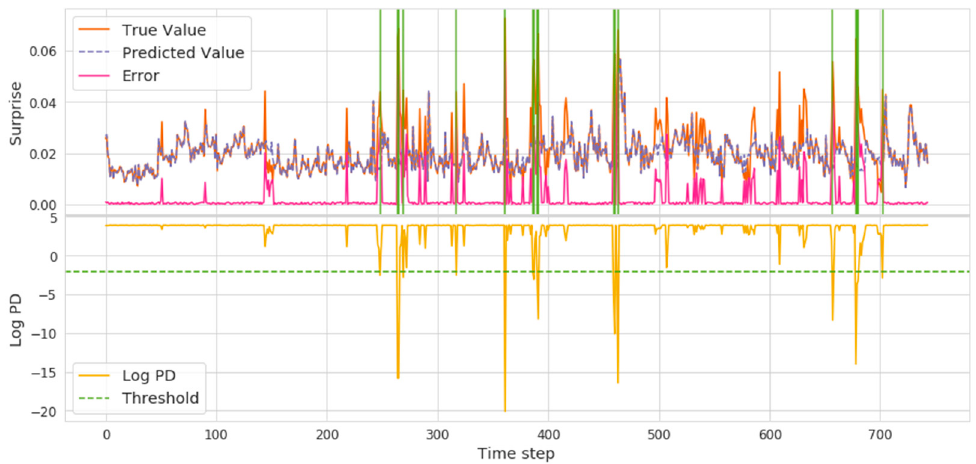
Figure 9. Surprise Volatility and Abrupt Time Points.